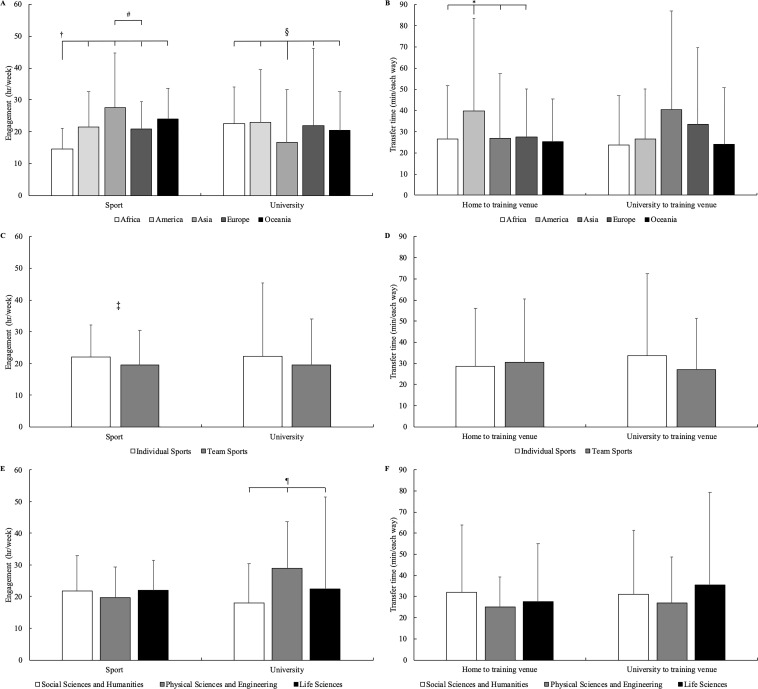
Means and standard deviations of weekly hours necessary for sport and university engagement and minutes necessary to transfer each way from home and university to the training venue in relation to continent (panel A and B), sport typology (panel C and D), and university major (panel E and F). †African student-athletes significantly different (p<0.05) from American, Asian, European, and Oceanic counterparts. #Significant difference (p = 0.017) between Asian and European student-athletes. §Asian student-athletes significantly different (p<0.05) from African, American, European, and Oceanic counterparts. *American student-athletes significantly different (p<0.05) from African, Asian, and European counterparts. ‡Significant difference (p = 0.03) between individual and team sports. ¶Significant differences (p<0.05) among the three university major categories.